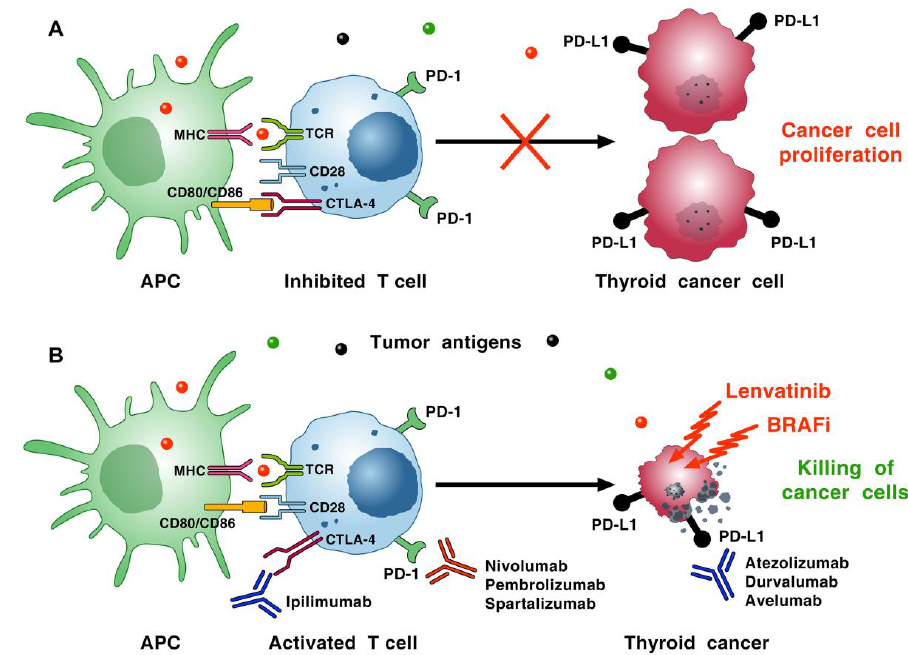
Figure 2. Schematic representation of the rationale developing combinatorial therapies of advanced thyroid cancer involving immune checkpoint inhibitors (monoclonal antibodies (mAbs) anti-cytotoxic T lymphocyte antigen 4 (anti-CTLA-4), anti-programmed cell death protein-1 (anti-PD-1), or anti-programmed cell death ligand-1 (anti-PD-L1)), BRAF inhibitors (BRAFi), multi-targeted tyrosine kinase inhibitors (TKIs) (e.g., lenvatinib), chemotherapies, or radiotherapies. ( A ) Cancer cells release neoantigens (dots of di ff erent colors) that are captured by antigen-presenting cells (APCs). These cells presentpeptidesinthecontextofMHCImolecule / Tcellreceptor(TCR)onthesurfaceofCD8 + cytotoxicT cells. APCscanalsopresentpeptidesboundtoMHCIImoleculesonCD4 + Thelpercells.